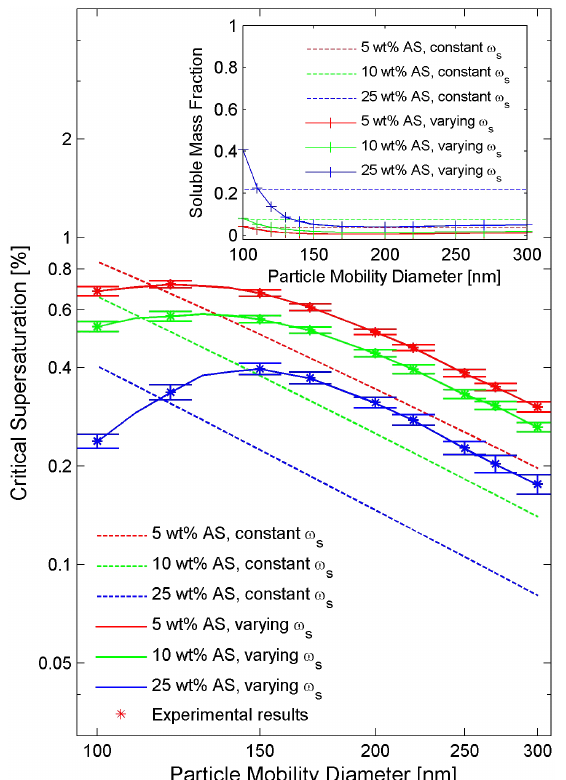
Figure 9. Experimental and theoretical critical supersaturations for mixed silica + (NH 4 ) 2 SO 4 (AS) particles for different particle mo- bility diameters using the model of Kumar et al. (2011b). Dashed lines represent calculated critical supersaturations based on an as- sumption of constant soluble mass fractions ( ω s ) with changing diameter and solid lines show the critical supersaturations based on the size-dependent soluble mass fractions. Error bars repre- sent the minimum vs. maximum values of supersaturation to es- timate the s c corresponding to each mobility diameter. The inset represents assumed constant soluble mass fractions as well as size- dependent ones corresponding to the 50% points in the CCN/CN curves for different size vs. supersaturation pairs of mixed silica + (NH 4 ) 2 SO 4 particles.